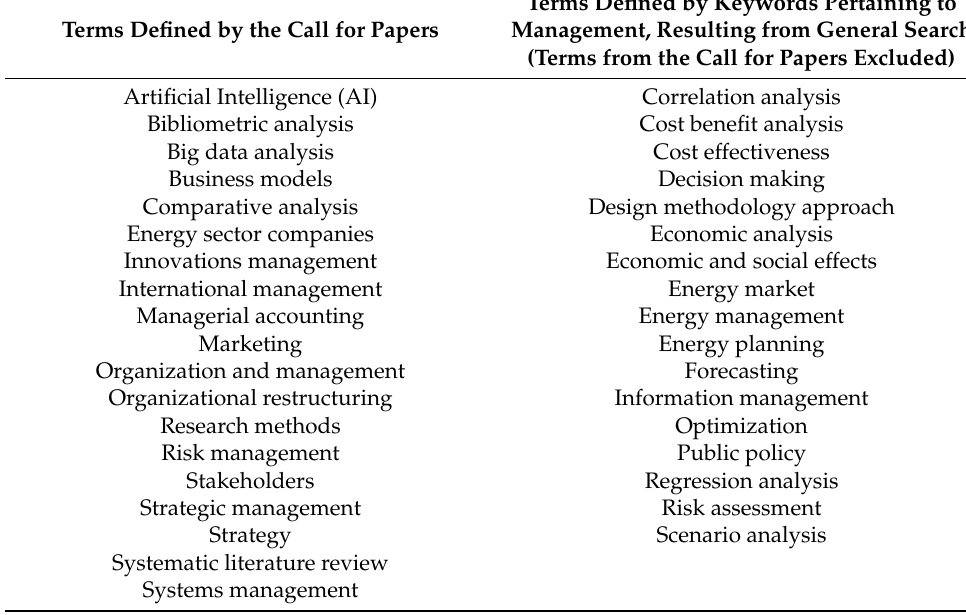
Table 1. Search terms (keywords) for Scopus database applied. Source: own study. Terms Defined by Keywords Pertaining to Terms Defined by the Call for Papers Management, Resulting from General Search (Terms from the Call for Papers